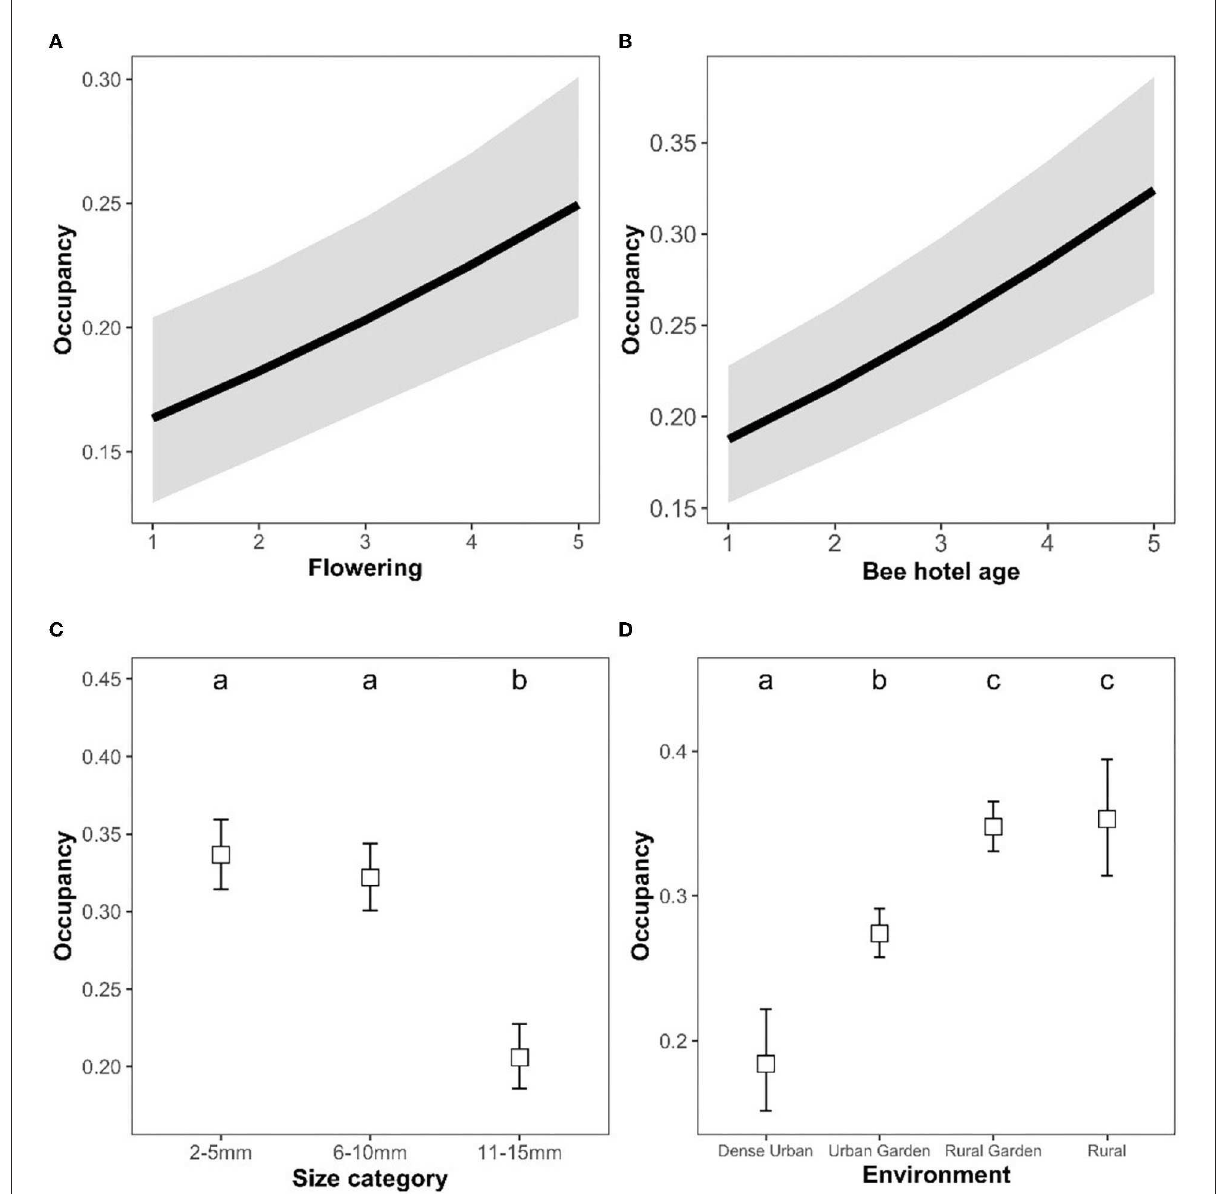
FIGURE4 Bee hotel nest occupancy (estimated marginal means ± 95% confidence levels) in relation to (A) local flower availability, (B) bee hotel age, (C) nest hole size (diameter), and (D) surrounding environment. Pairwise comparisons of estimated marginal means (C, D) are indicated by compact letter display. Means (of size category and environment, respectively) sharing a letter is not significantly